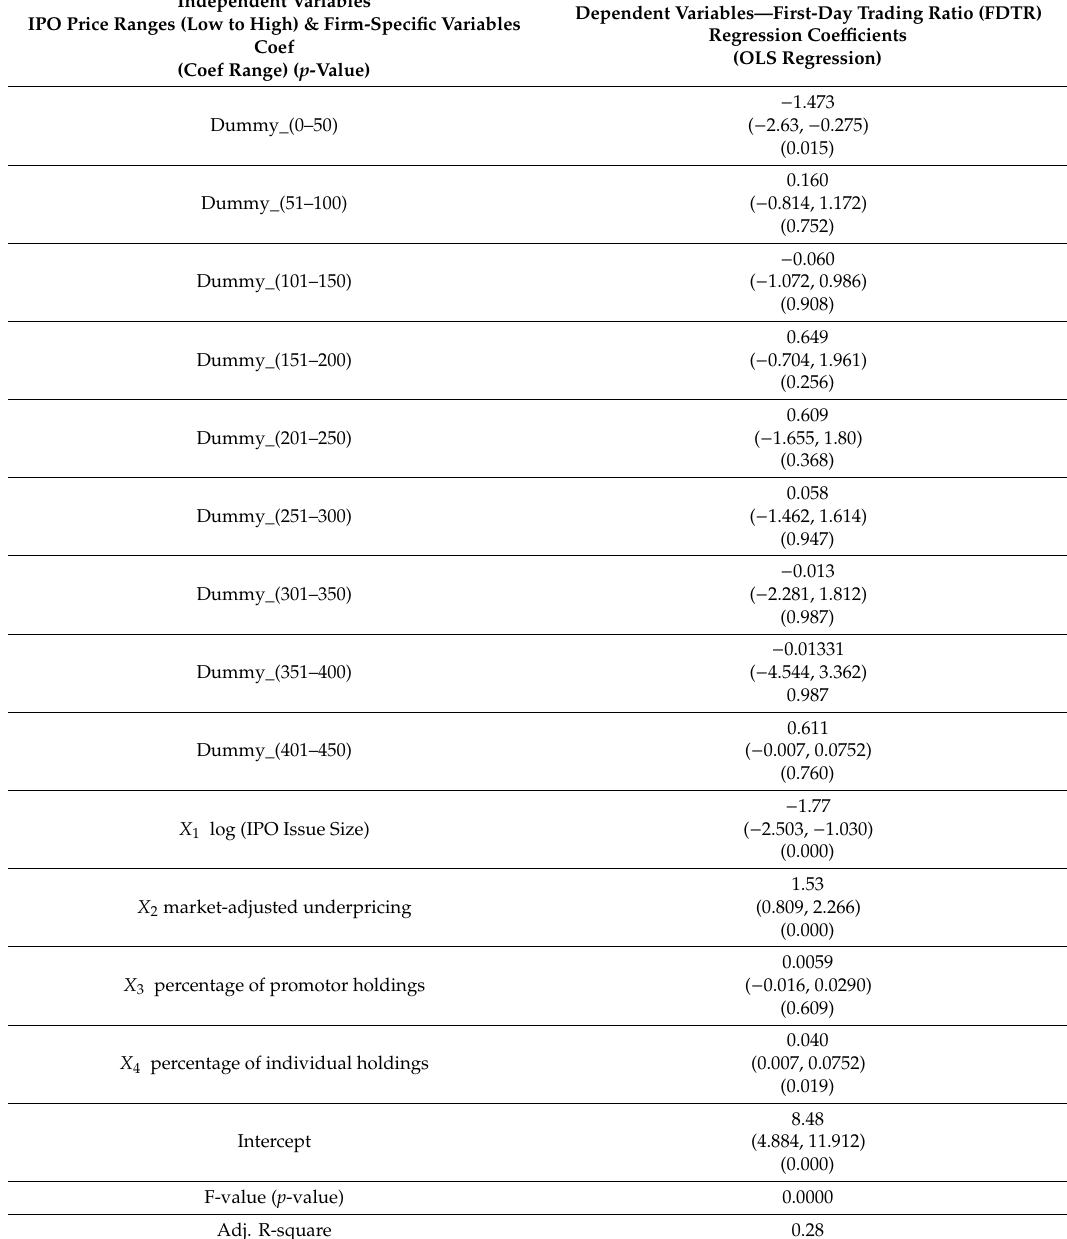
Table A2. Results of OLS regressions. The e ff ect of the IPO o ff er price ranges and the IPO issue characteristics on the